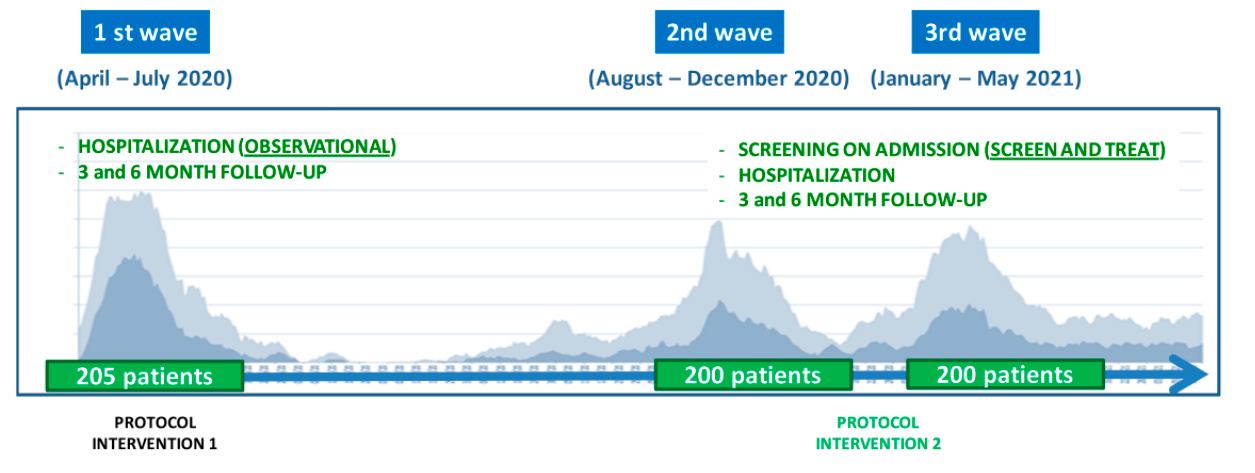
Figure 2. Curves of admission during the three waves of the pandemic at Consorci Sanitari del Maresme, Catalonia, Spain. A dark gray shadow depicts hospitalization, and a light gray shadow depicts visits to the emergency department.